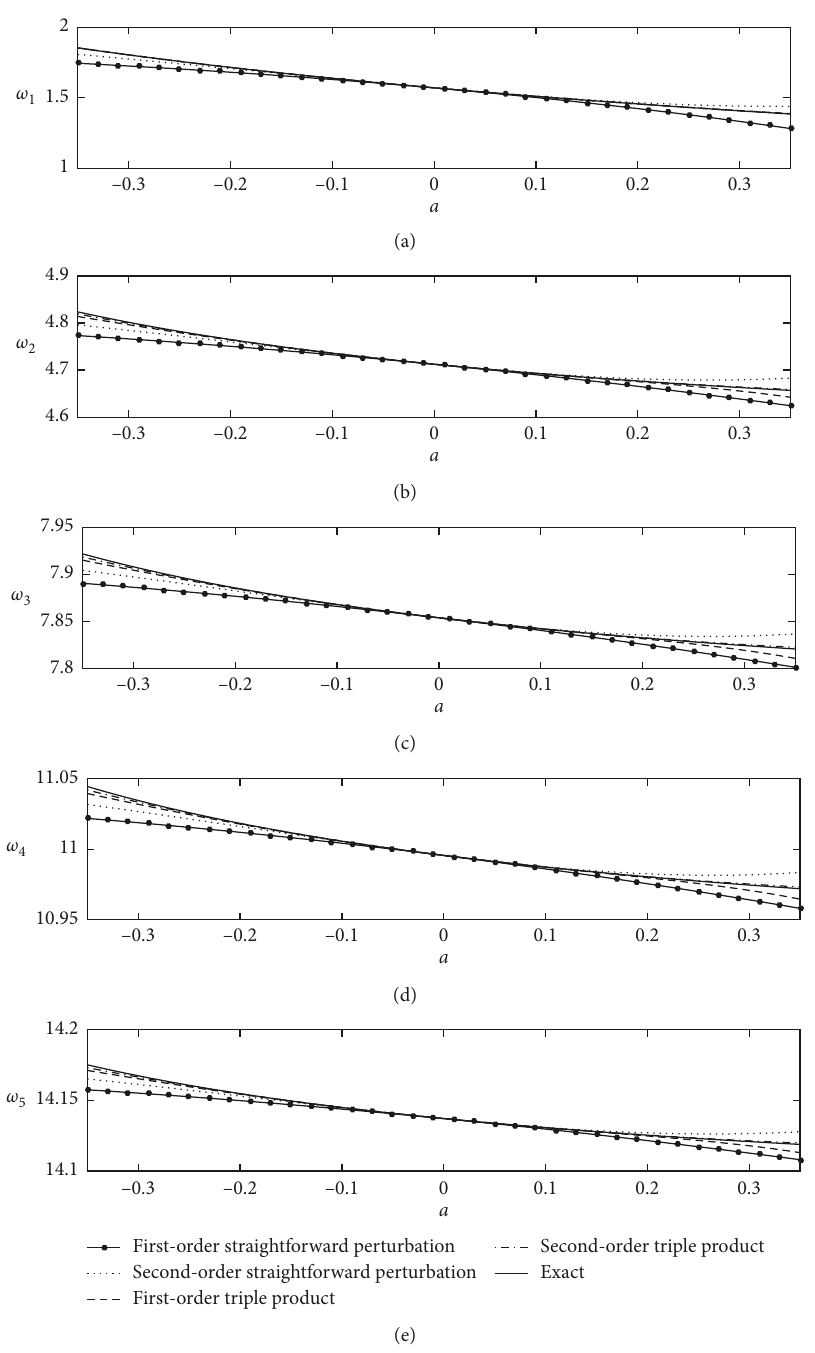
Figure 18: The first five normalized exact and approximate natural frequencies of the nonuniform rod as a function of a . The natural frequencies are nondimensionalized by dividing by